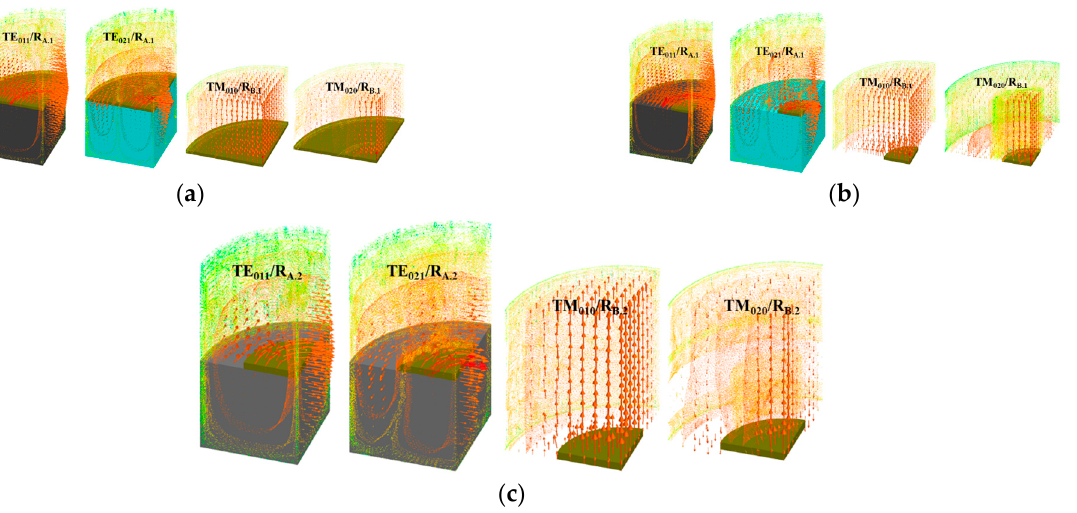
Figure 4. EM simulations of resonators R A and R B : when s d ~ D A , D B ( a ), s d < D A , D B ( b , c ).